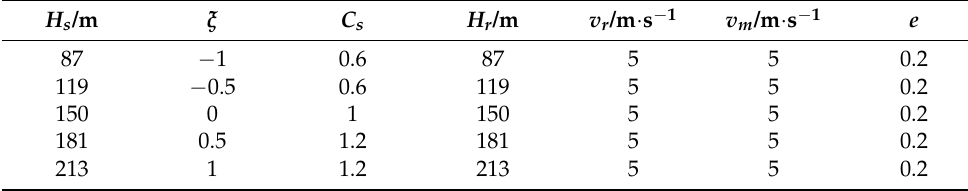
Table 5. Calculation parameters of various LLJ heights.